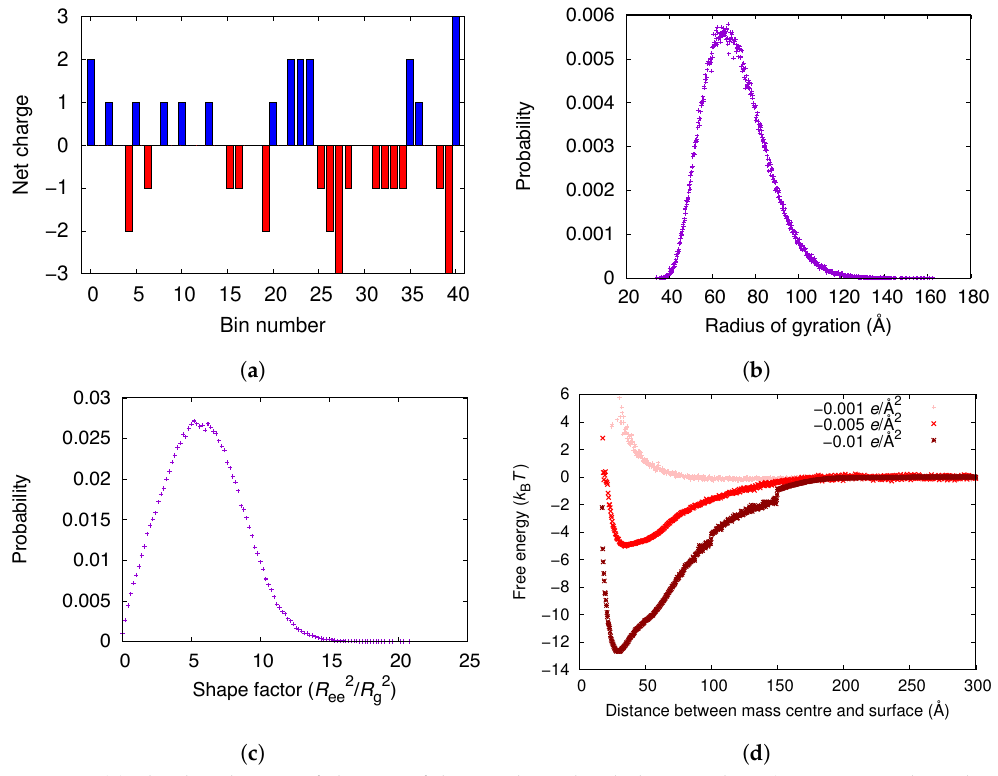
Figure 8. ( a ) The distribution of charges of the α C-chain divided into 41 bins (10 amino acid residues per bin) starting from the N-terminal. The negative charge of the C-terminal is included. ( b ) The distribution of the radius of gyration of the α C-chain in bulk. ( c ) The distribution of the shape factor of the α C-chain in bulk. ( d ) The adsorption free energies for the α C-chain to surfaces with different negative surface charge densities.